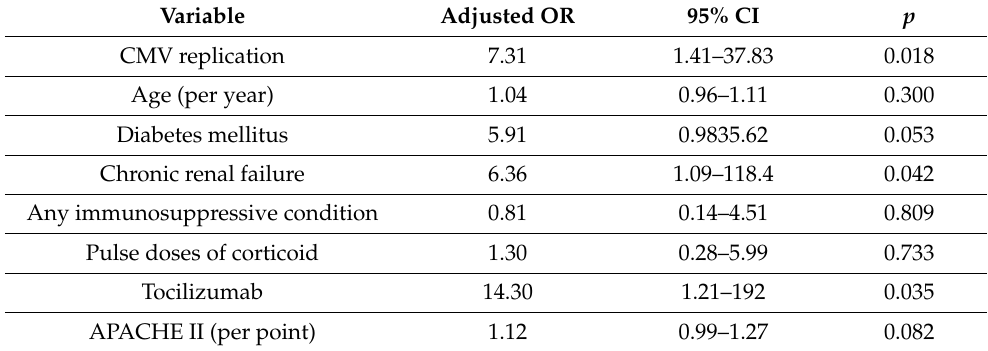
Table 2. Multivariate analysis of factors associated with COVID-associated pulmonary aspergillo- sis.